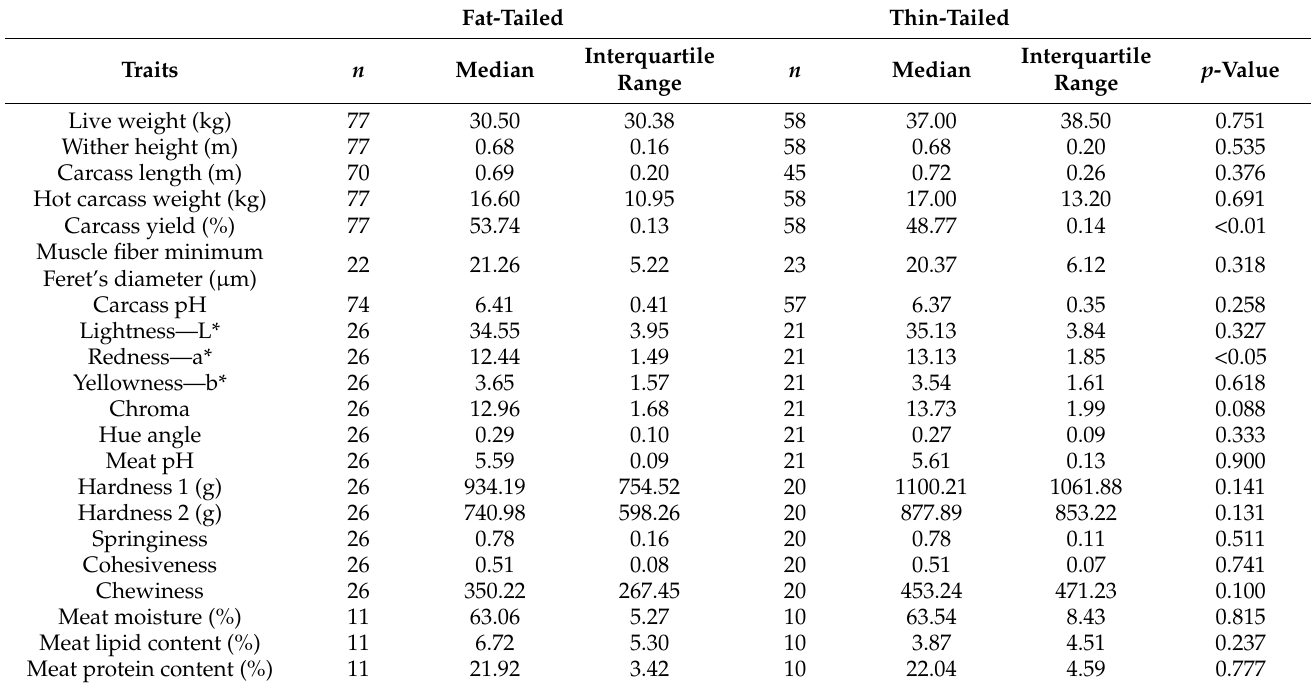
Table 5. Results of non-parametric Mann–Whitney U tests performed to compare fat-tailed sheep to thin-tailed sheep (rejection of null hypothesis when p < 0.05: Differences between medians of groups are statistically significant, hence groups come from different populations).